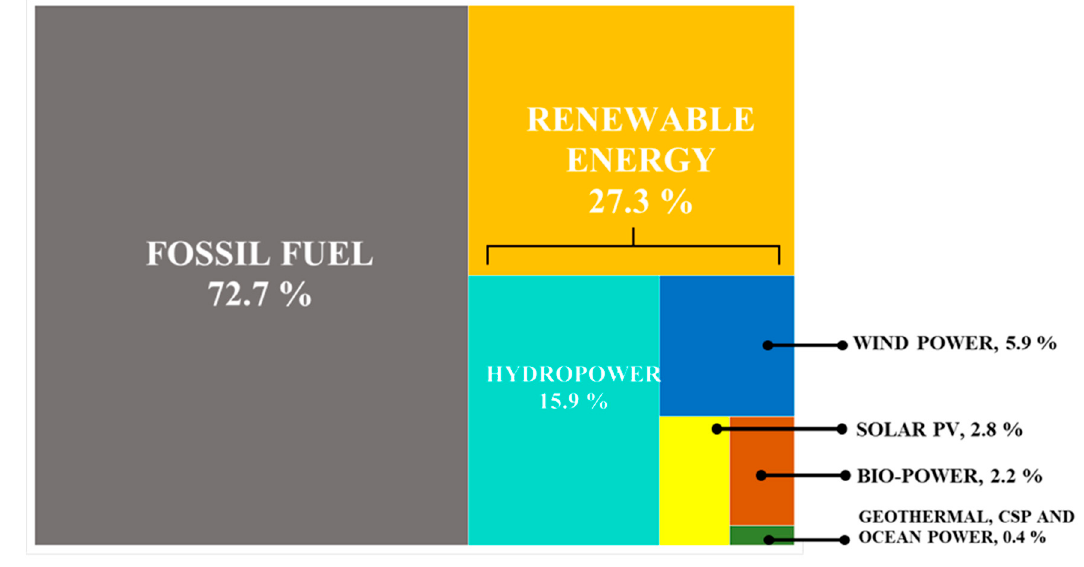
Figure 1. Global Energy Mix, 2019.